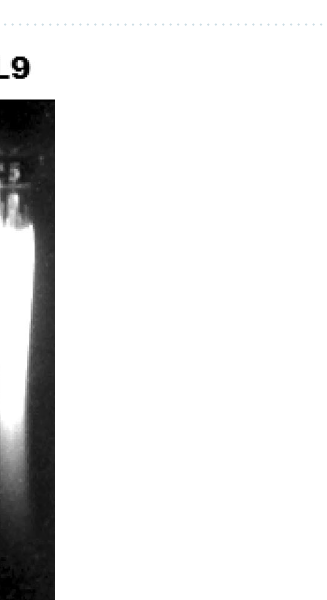
Figure 5. Graded doses of sodium azide significantly ( p < 0.001) affect antioxidant activity of callus extract of Nigella sativa that also significantly ( p < 0.001) corresponds to in vitro calf DNA damage inhibition (%). Vertical bars refer to ± standard deviation and histograms bearing the different alphabets in a series of data are significantly different from each other (Tukey’s HSD test).